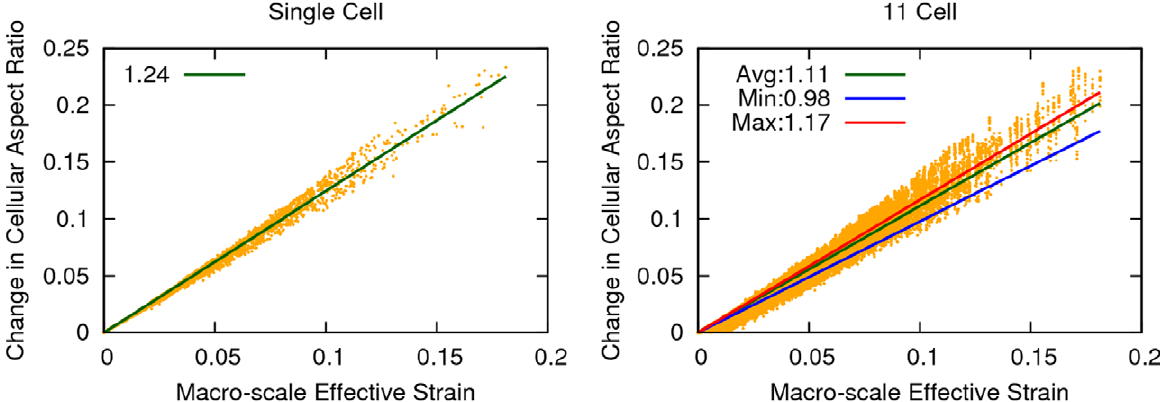
Figure 6. The change in cellular aspect ratio measured in each micro-scale model for the single cell (left) and 11 cell (right) cases was plotted as a function of macro-scale effective strain occurring at the corresponding finite element. The solid lines were linear least- squares regressions performed with the requirement that the lines passed through the origin. The slopes of each of these lines were provided in the legend. In the 11 cell case, the line labeled ‘‘Max’’ considered only data from the cell which experienced the greatest change in aspect ratio. Likewise, the line labeled ‘‘Min’’ was the cell which experienced the least change in aspect ratio, and the ‘‘Avg’’ was the average of the linear regressions for all 11 cells. These slopes indicated the distribution of the 11 cell change in aspect ratios was skewed left.